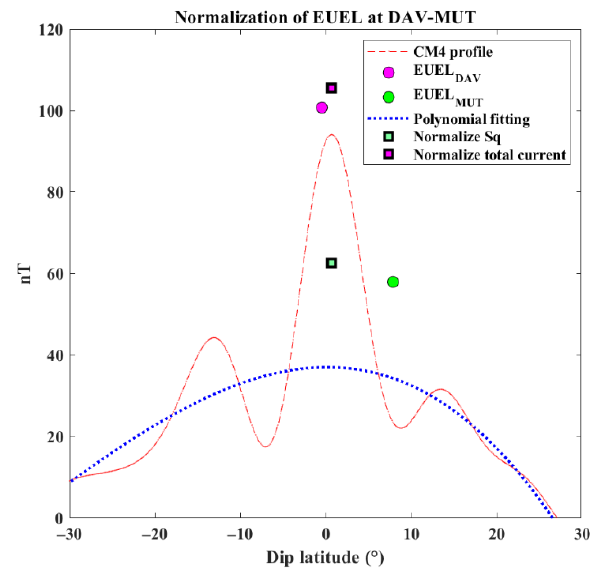
Figure 1. An example of normalization method of the EUEL index at the Southeast Asian sector (DAV–MUT stations pair).